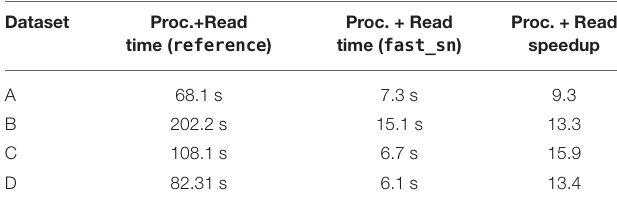
TABLE 1 | reference vs. fast_sn : processing time (in seconds) and fast_sn speedup.